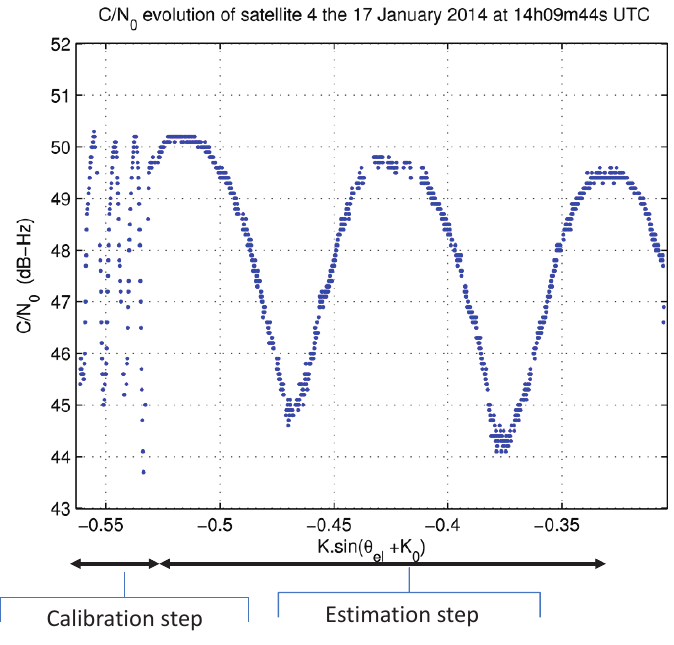
= 2 . 13 m and ∆ x = 1 . 92 m. for h 0 ref